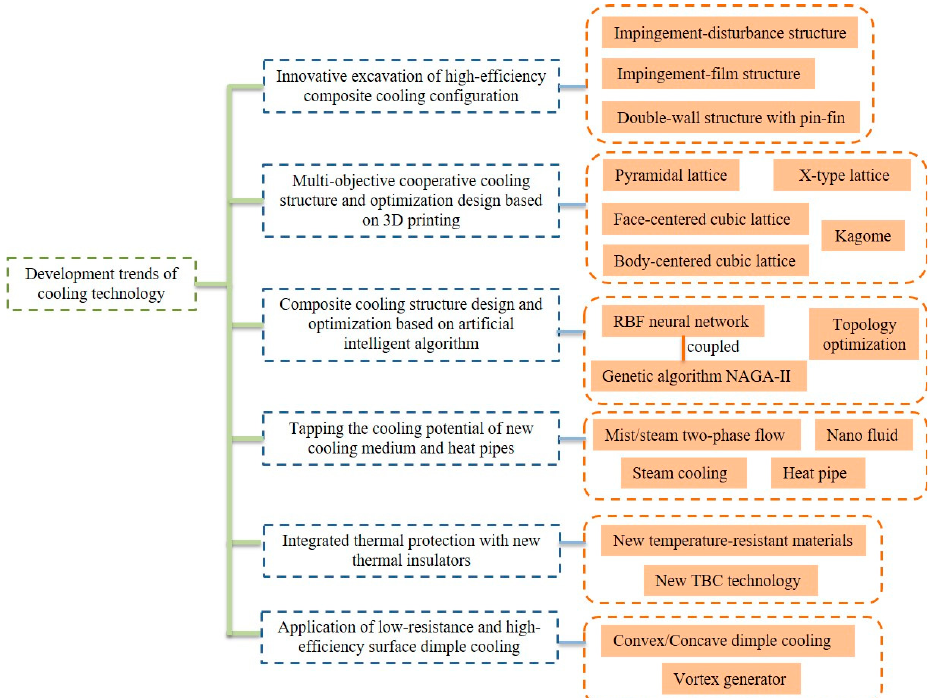
Figure 8. Development trends of cooling